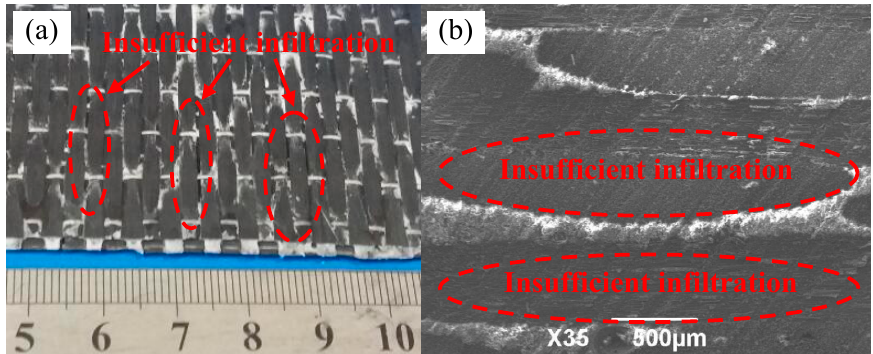
Figure 4. Imperfection of impregnation of 2D-T700/E44 composite prepared by ICM ( a ) Macrograph of imperfection impregnation; ( b ) Micrograph of imperfection impregnation.